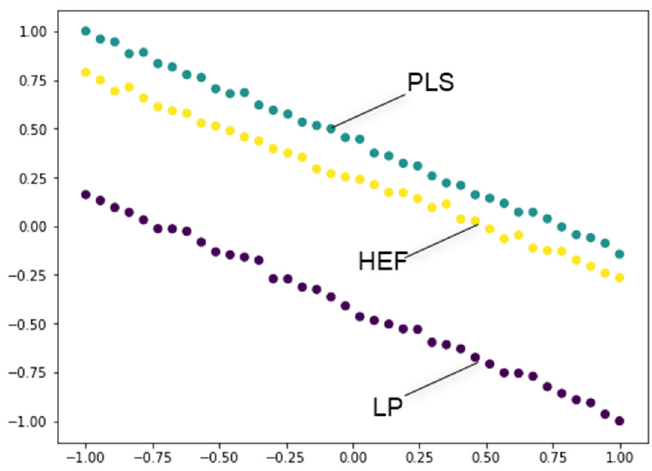
Figure 17. Data set categorized by implant type.